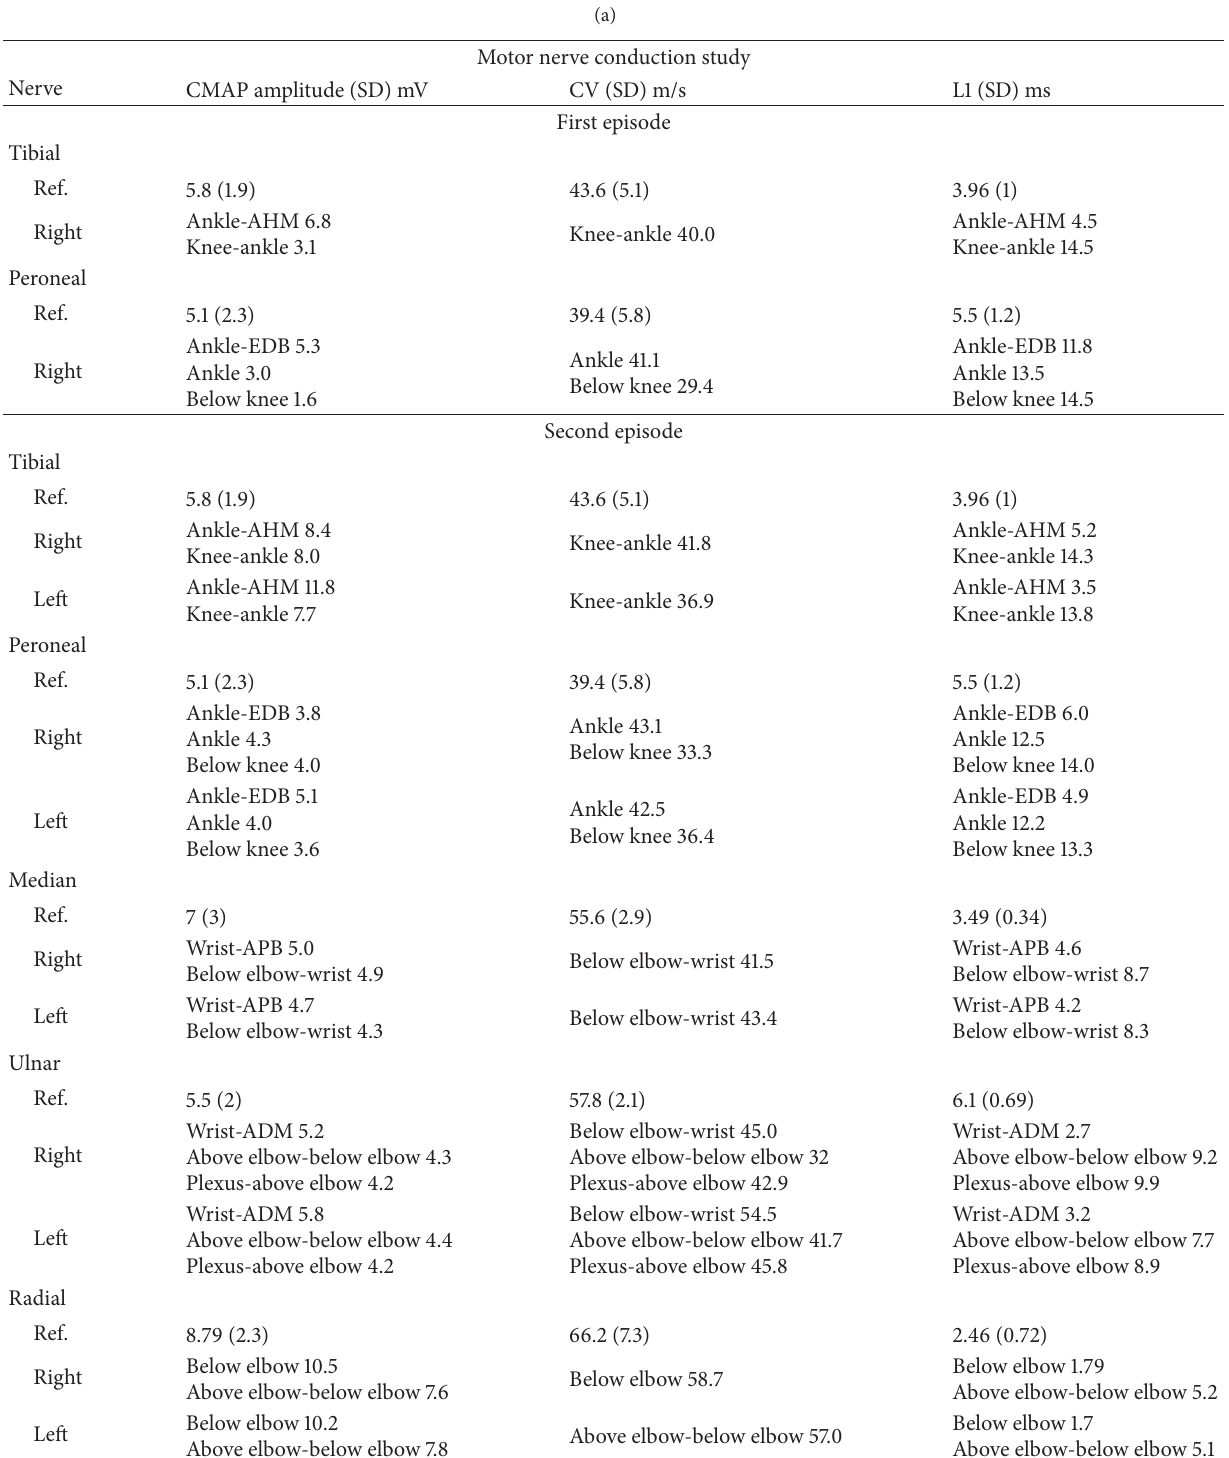
Table 1: Nerve conduction